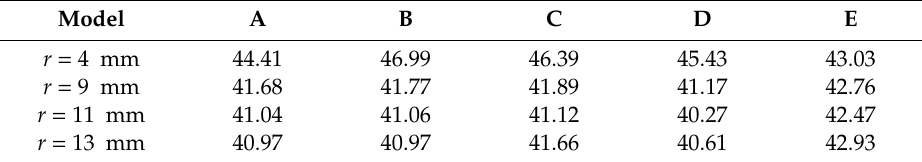
Figure 24. Positions of microphones in the aeroacoustic test. ( a ) Top view of the positions of the probes; ( b ) side view of the positions of the probes. Table 5. The sound pressure level monitored by different microphones (dB).